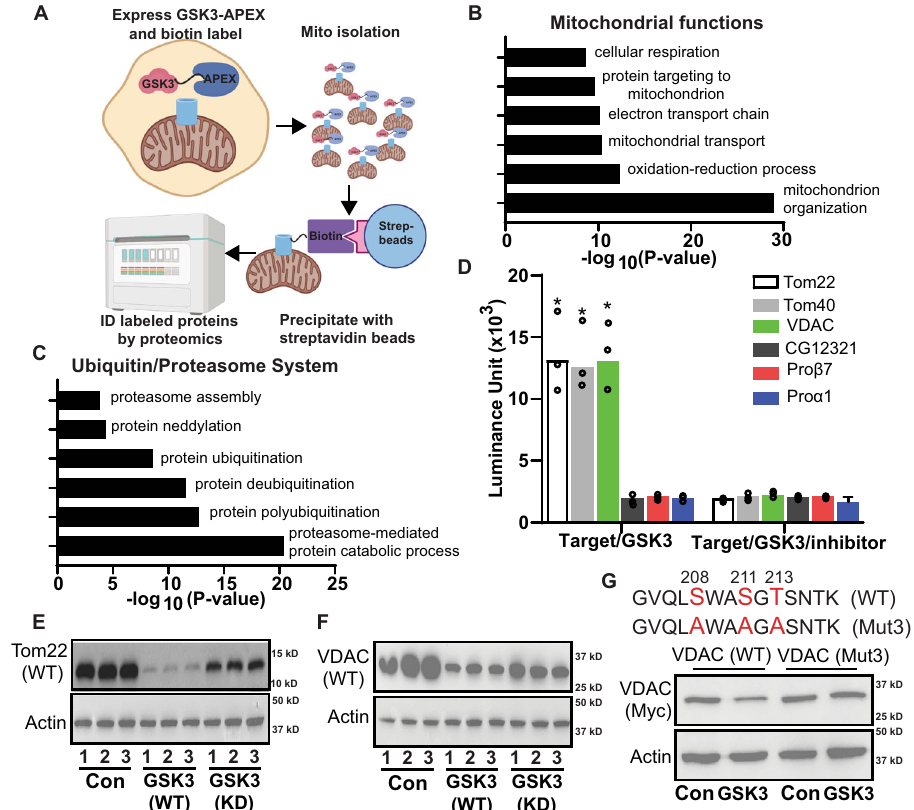
Fig. 3 | GSK3 phosphorlaytes mitochondrial outermembrane proteins and controls their turnover. A Experimental strategy to identify mitochondrial GSK3 interacting partners during quiescence. Created with Biorender. GO term analysis of proteins involved in mitochondrial functions ( B ) and Ubiquitin/proteasome system ( C ) identi fi ed by GSK3-Apex2 proximity labeling. D In vitro kinase assay tests GSK3 candidate targets identi fi ed in ( B ) (Tom complex components and VDAC) and ( C ) (UPS components) ( n =3 experimental replicates). Validation of GSK3 Kinase targets TOM22 ( E ) and VDAC ( F ) in 293T cells ( n =4 experimental mitochondrial organization (Fig. 3B), consistent with data showing GSK3 suppresses mitochondrial oxidative metabolism and drives